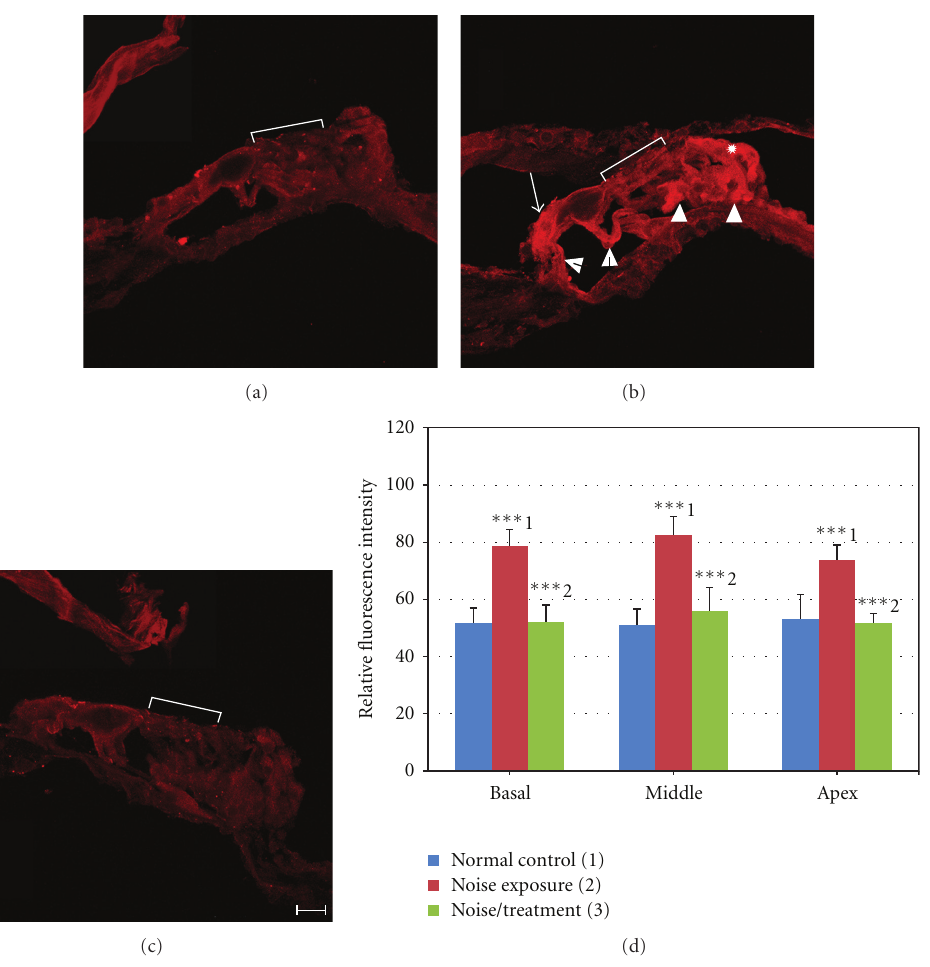
Figure 4: 4-HNE immunostaining and relative fluorescence intensity in the organ of Corti. Examples of 4-HNE immunostaining images obtained from the organ of Corti in the middle turn of cochleae from the normal control (a), noise exposure (b) and noise/treatment (c) groups by confocal microscopy using the same microscopic and image collecting settings. No significant 4-HNE staining was found in the organ of Corti of the normal control group (a). Strong positive staining was seen in IHC (arrow in (b)), inner and outer pillar cells (open arrowheads in (b)), Deiters cells (arrowheads), and cells of Hensen (starburst) and Boettcher of the noise exposure group. The OHC region also had positive, but relatively weak 4-HNE immunostaining (bracket in B). Significantly lower HNE staining was found in the organ of Corti in the noise/treatment group (c). The results of the relative fluorescence intensity in the organ of Corti measured by LAS AF Lite software are shown in (d). High fluorescence intensity was found only in the organ of Corti of the noise exposure group. There were significant di ff erences among three groups and between the normal control and the noise exposure groups, as well as between the noise exposure and the noise/treatment groups ( ∗∗∗ indicates P < 0 . 001). However, there was no significant di ff erence between the normal control and the noise/treatment groups ( P > 0 . 05). There was no significant di ff erence among three turns within each group ( P > 0 . 05). The numbers (1, 2, 3) in (d) indicate the normal control, noise exposure and noise/treatment groups, respectively. Brackets indicate the OHC region in (a)–(c). Scale bar = 20 μ m in (c) for (a)–(c) (Error bars represent standard error of the means. Number of cochleae = 6 in each